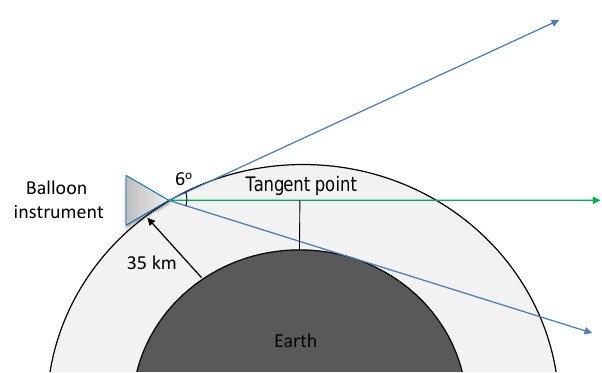
Figure 3. ALI in a stratospheric balloon geometry showing the complete 6 ◦ field of view in blue with a float altitude of 35km. The green line shows a typical vertical line of sight where the tangent point or altitude is set by the minimum distance between the earth and the line of